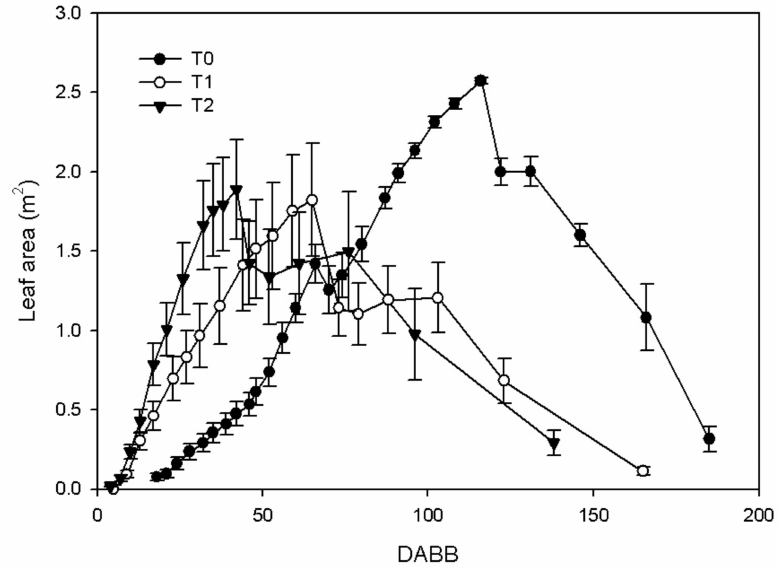
Figure 1. Leaf area (mean ± SE) of T0, T1, and T2 vines ( n = 4) vs. day after budburst (DABB). Vines were removed from the refrigerated growth chamber on DOY 76, 123, and 157, respectively, 47 and 81 days later from the first timing (T0), and transferred to outside growing conditions. Between budburst and shoot topping, on average, T min , T mean, and T max were, respectively, 11.5, 17.9, and 24.1 ◦ C for T0 treatment, 17.2, 24.6, and 31.9 ◦ C for T1 treatment and 18.9, 26.3 and 33.4 ◦ C for T2 treatment (Figure 2A). Budburst occurred on DOY 90, 133, and 160 for the T0, T1, and T2 treatments, respectively (Figure 2B). The time elapsed between transferring the vines from the refrigerated growth chamber to the outside conditions and budburst was reduced in the T1 and T2 treatments when compared to the T1 or T0 treatment. In T0, the mean daily temperature at budburst was 15.5 ◦ C, while in T1 and T2, it was 20.1 and 25.5 ◦ C, respectively. In T0 mean daily temperature at full bloom was 21.1 ◦ C, while in T1 and T2, it was 21.8 and 22.7,